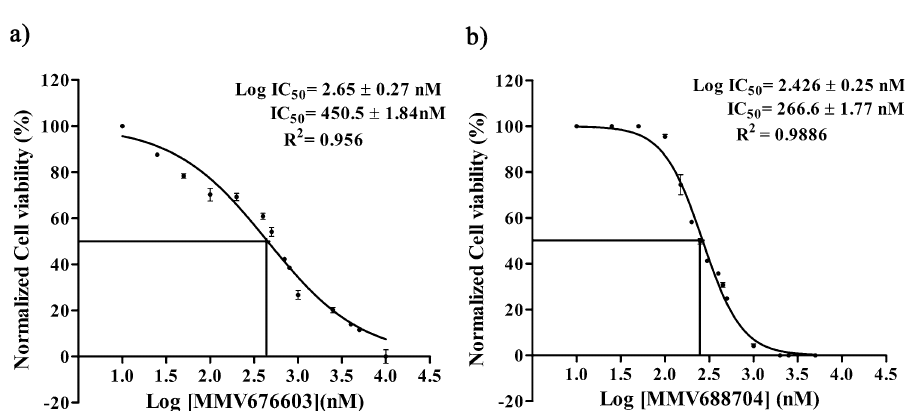
Figure 7. IC 50 determination of MMV676603 and MMV688704 from Pathogen Box against blood stage of P. falciparum 3D7: dose–response curve indicating the Log IC 50 , IC 50 and R 2 values of ( a ) MMV676603 and ( b ) MMV688704 against asexual stages of P. falciparum 3D7. Inhibition at each data point is depicted as Mean ± S.D. of three independent